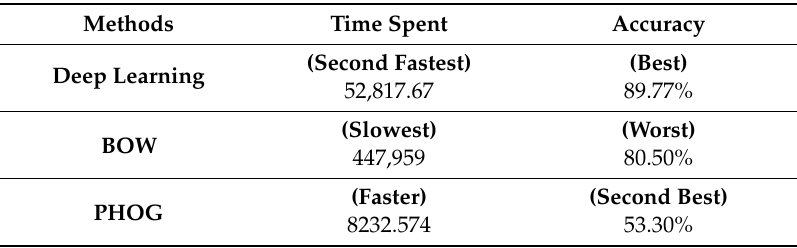
Table 6. Running time and accuracy comparisons among the four